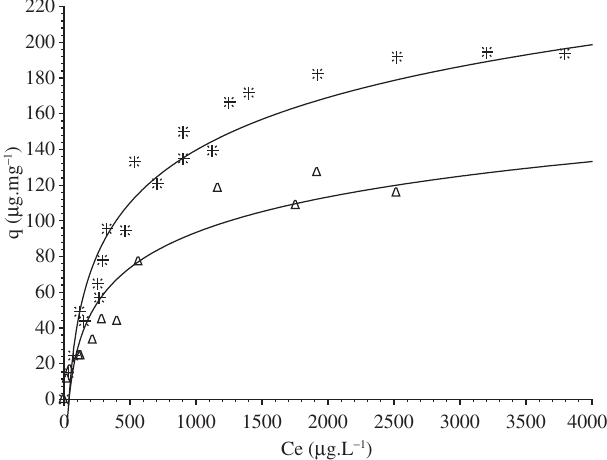
Figure 5. Adsorption equilibrium of [D-Leucine 1 ]MCST-LR onto the surface pine wood ACF and ∆ sugarcane bagasse ACF.